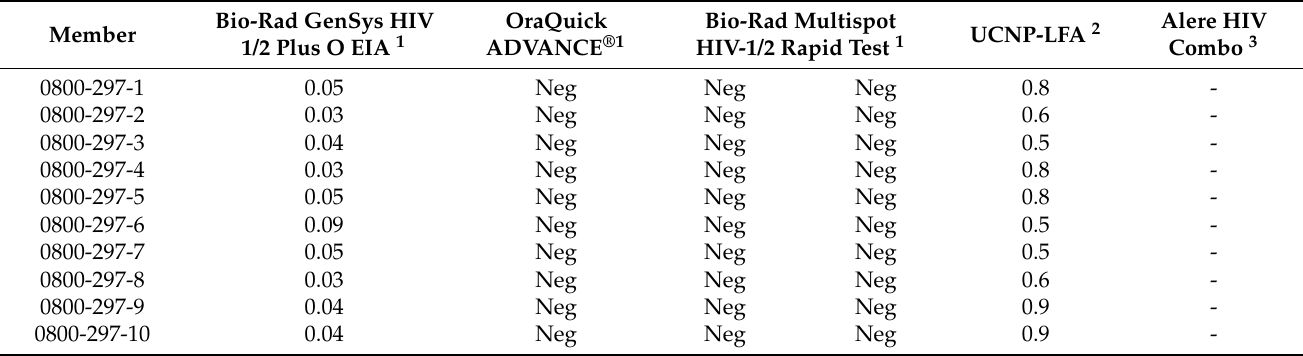
Table 7. HIV-1 Early Infection Performance Panel